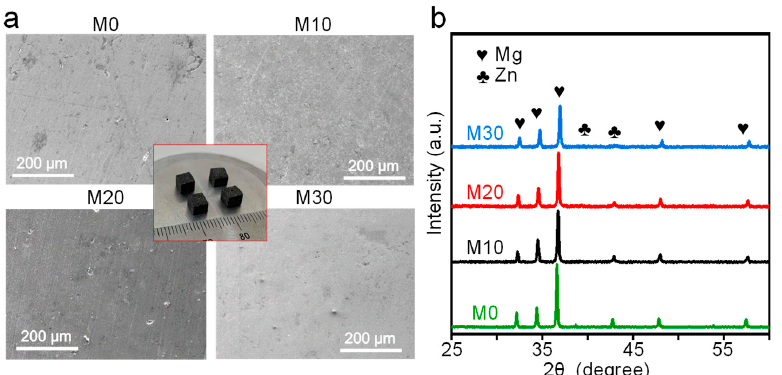
Figure 5. ( a ) Laser-sintered parts and corresponding surfaces after polishing. ( b ) XRD patterns of laser-sintered samples.